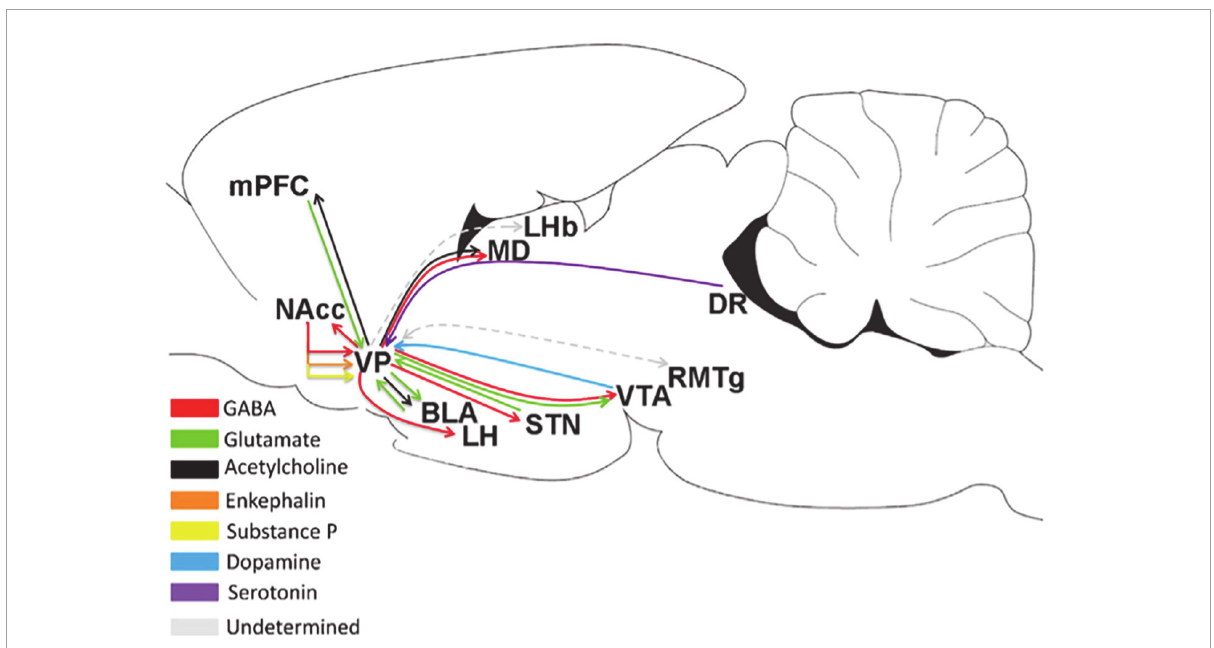
FIGURE2 Upstream and downstream projections of the VP in the neural circuits of the brain (Root et al., 2015). MD, medial thalamus; DR, dorsal raphe; STN, subthalamic